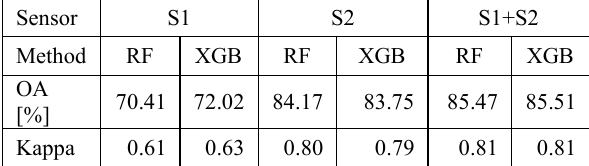
Table 4. OA and Kappa values of RF and XGB, as applied to